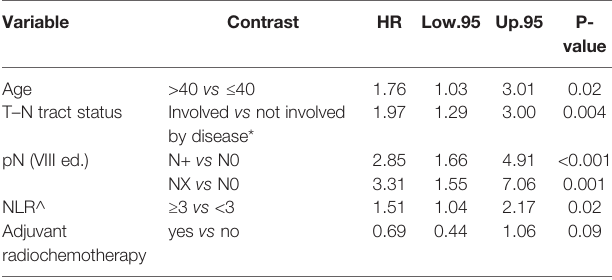
not involved by disease*